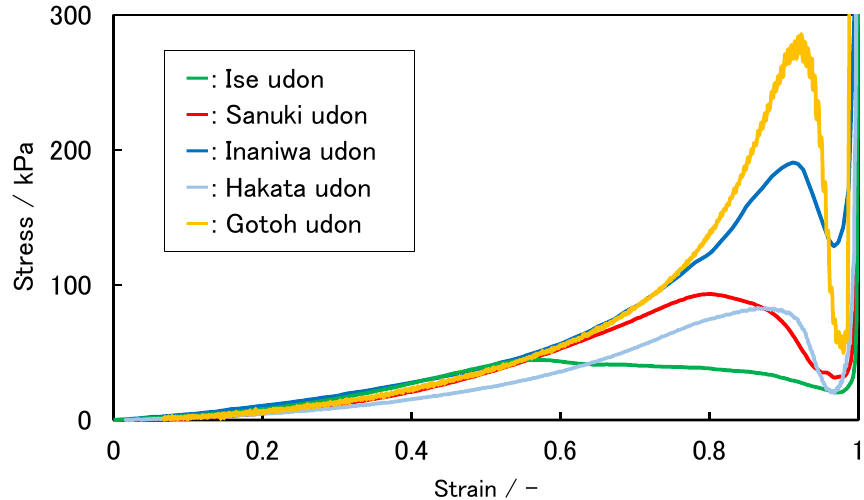
Figure 1. Representative stress–strain curves of various udon noodles: a representative measurement result of each condition.